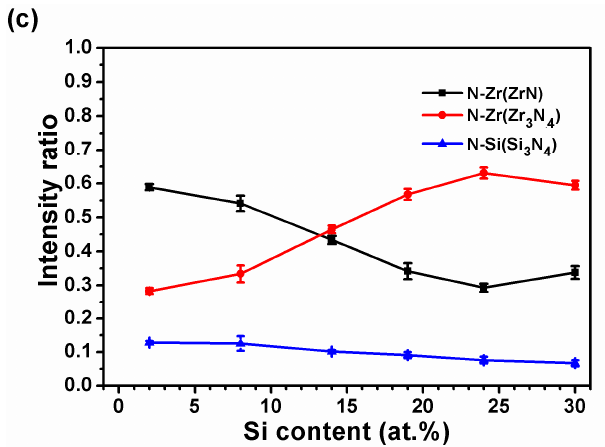
Figure 9. XPS signal ratios of ( a ) Zr; ( b ) Si; and ( c ) N of Zr–Si–N(0.4,R5) coatings.